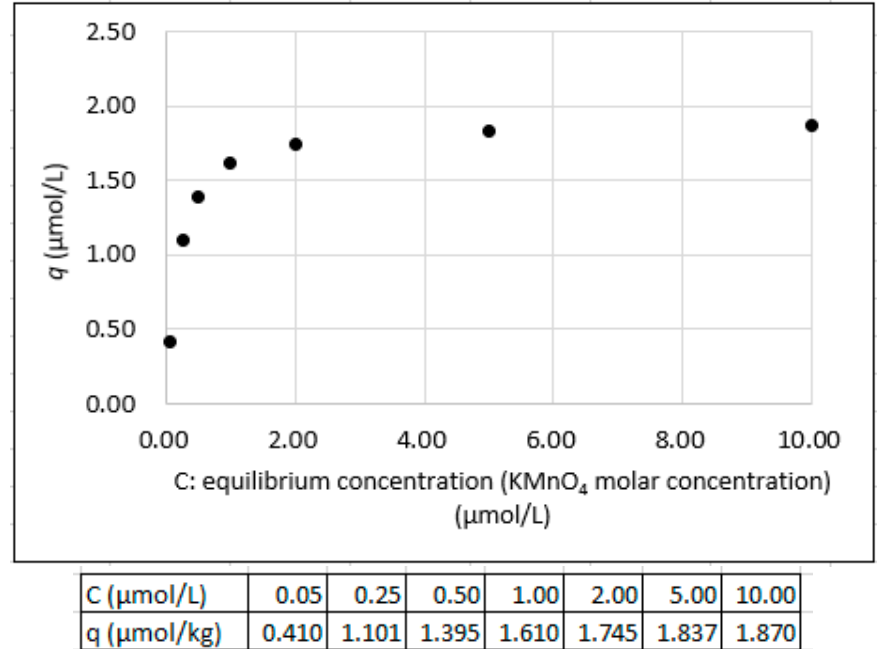
Figure 5. Expected amount of adsorption at various concentrations. The adsorption amount was calculated by implementing measured values in the Langmuir adsorption formula.